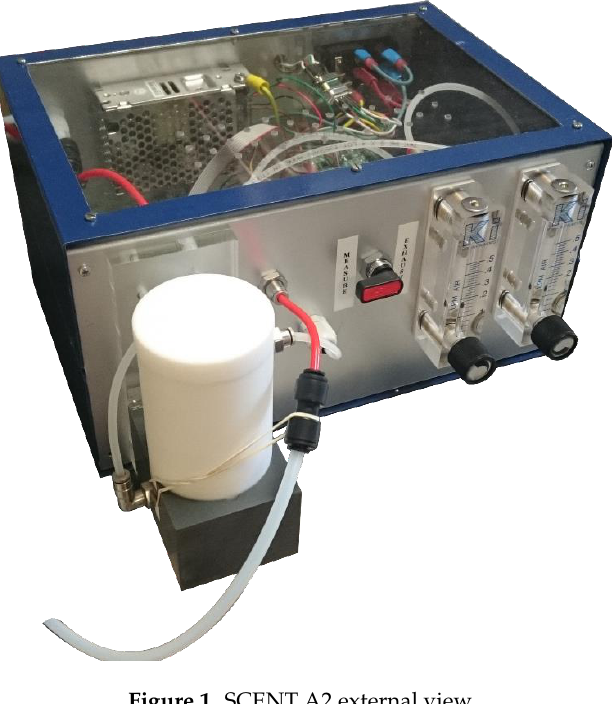
Figure 1. SCENT A2 external view.